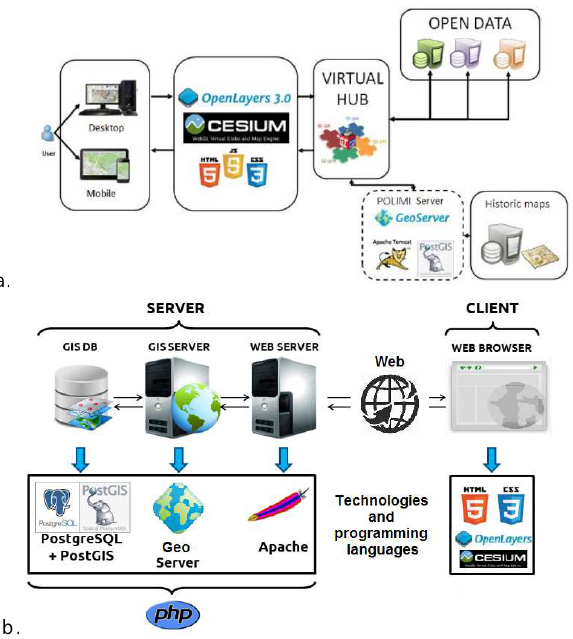
Figure 3. GeoPAN Atl@s architecture (a) and server-client architecture of POLIMI Server